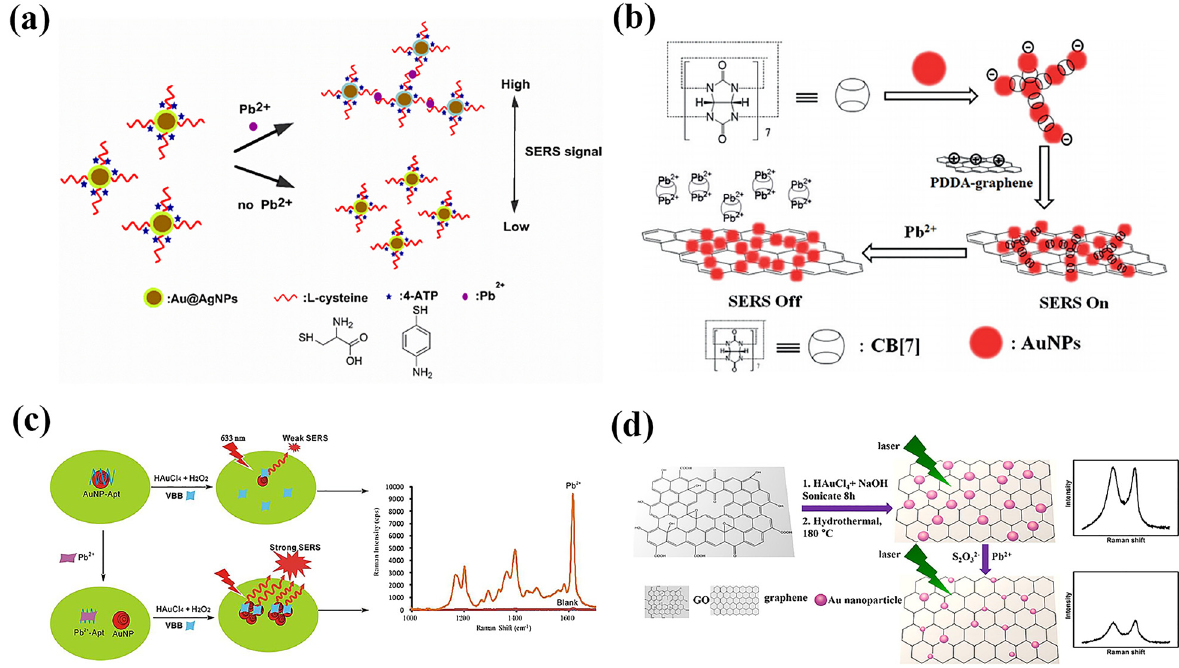
Figure 8: Detection of Pb 2 + ions with various special strategies. (a) Au@AgNPs functionalized with L -cysteine self-aggregated in the presence of Pb 2 + ions [131]. (b) CB[7] complexed with Pb 2 + ions and separated from the surface of G/AuNPs/CB composite [132]. (c) AuNP nanozyme accelerated the redox reaction of HAuCl 4 -H 2 O 2 to form more AuNPs [133]. (d) Pb 2 + ions sped up the dissolution of AuNPs on the surface of graphene in the presence of S 2 O 3 2 − [135].